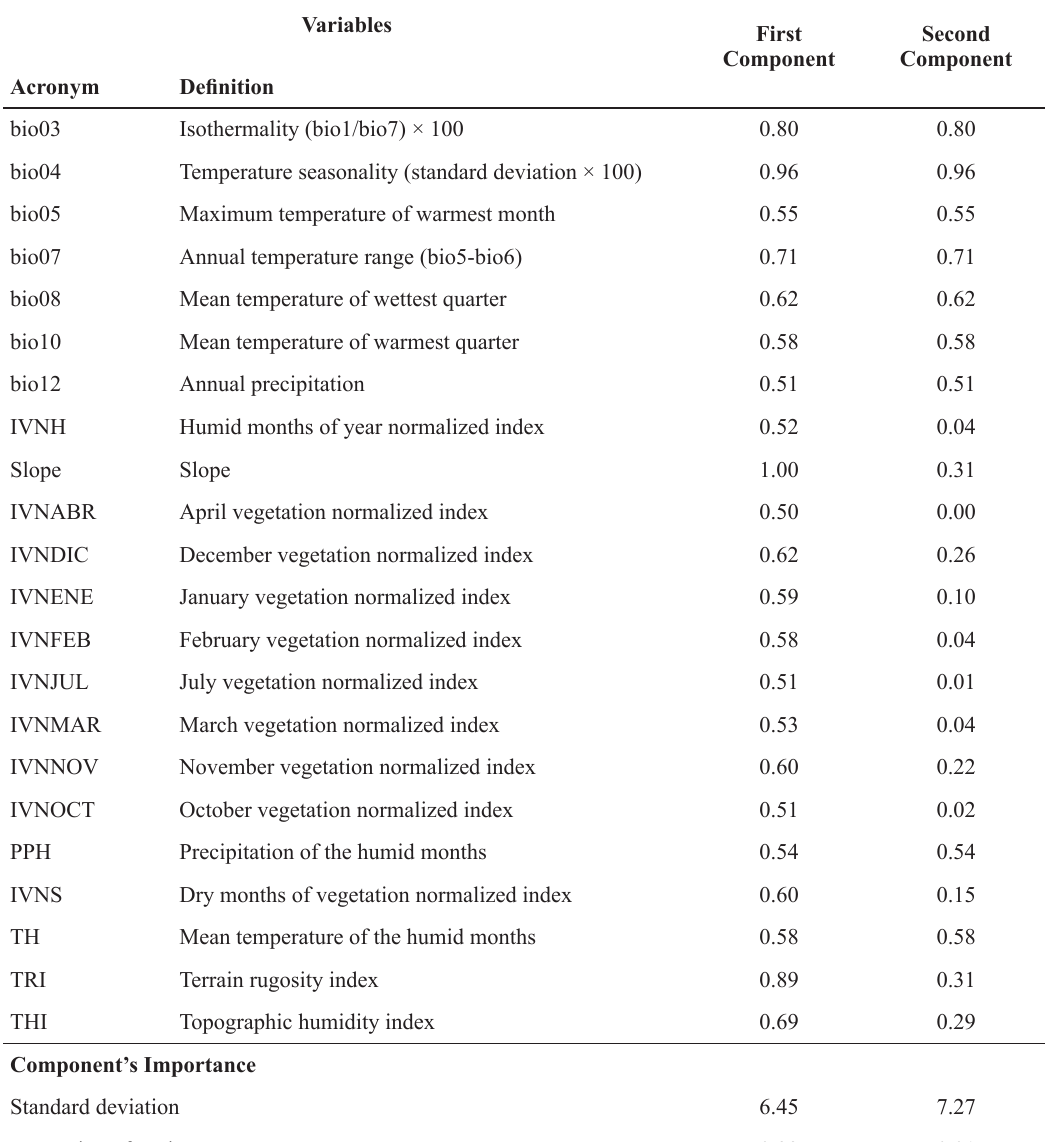
Table 3 – Contributing values of the environmental variables selected using the principal component analysis to carry out the potential distribution models of the Zaluzania